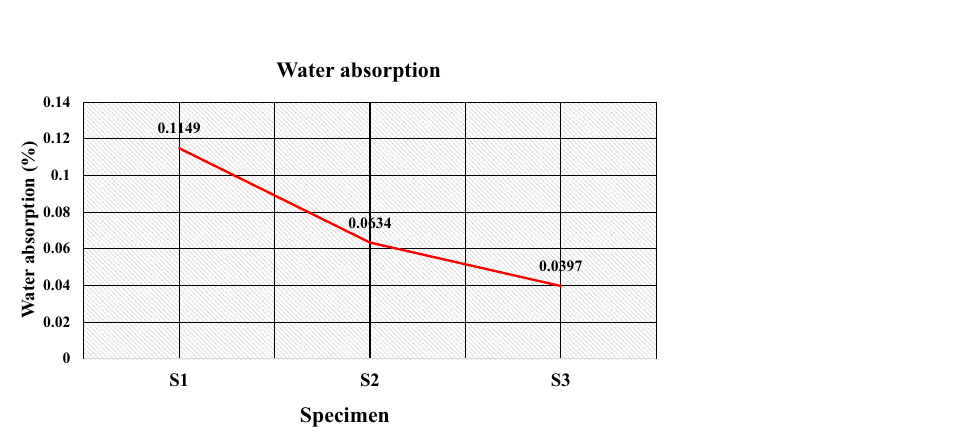
Figure 11. Water absorption (%) of the